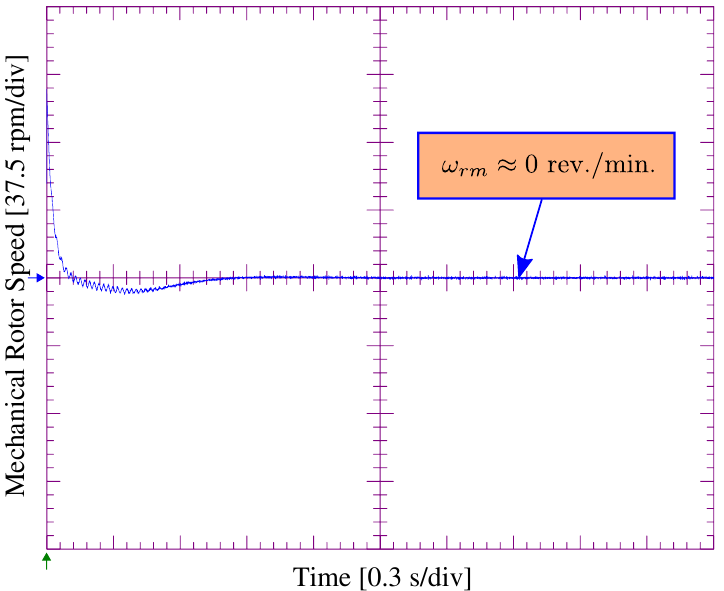
Figure 11. Mechanical rotor speed of the proposed zero angle LFS injection based PMSM drive with FSTP inverter. Operating at: 0.25 pu d -axis voltage and zero q -axis voltage with 10 kHz switching frequency under fan type loading